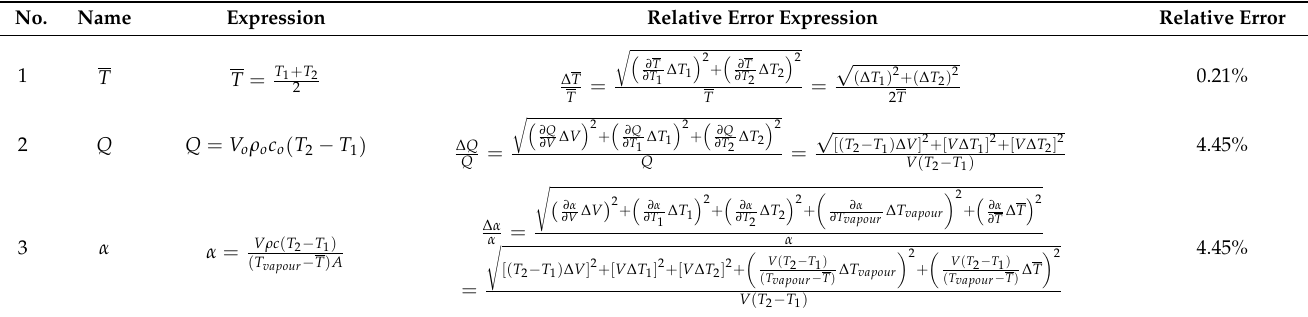
Table 5. The relative error of the indirect measured value of the instrument in the experimental platform system.